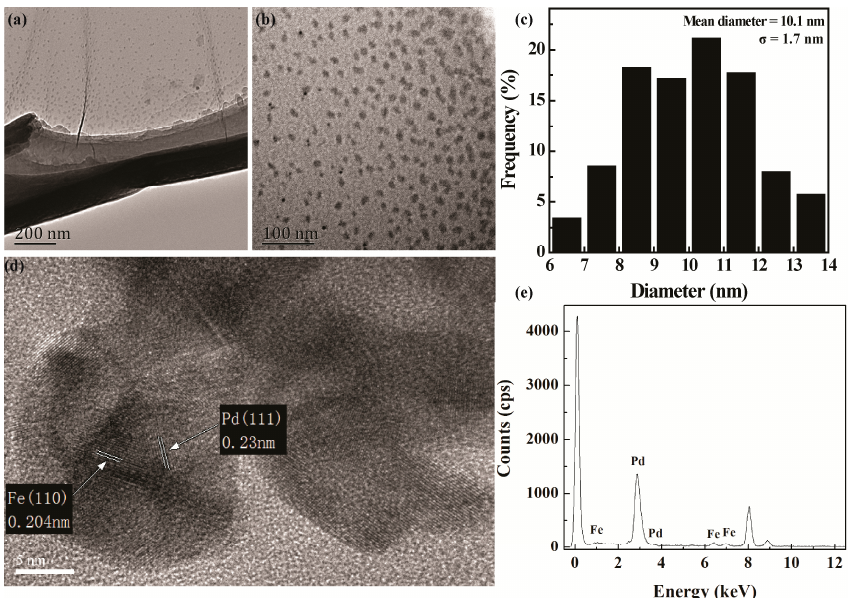
Figure 2. ( a ) Transmission electron microscopy (TEM) image, and ( b ) enlarged TEM image of the iron / palladium nanoparticle (Fe / Pd NP)-assembled filter paper from the cross-section. ( c ) Diameter distribution histogram of Fe / Pd NPs. ( d ) High-resolution TEM image of the Fe / Pd NPs. ( e ) Energy-dispersive spectrum (EDS) spectrum of the Fe / Pd